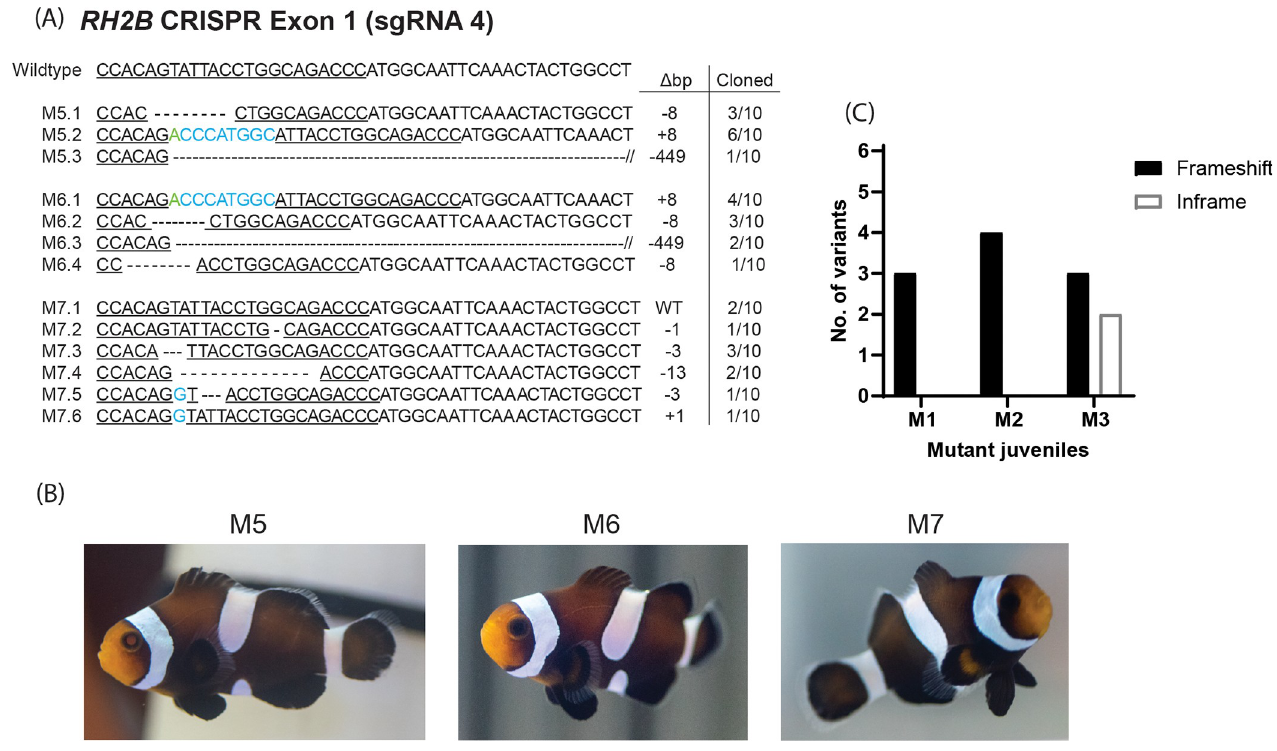
Fig 4. Genotype analysis of four-month-old RH2B mutant Amphiprion ocellaris . (A) Subcloned sequences belonging to A . ocellaris juveniles (clutch 11, sgRNA RH2B 4) with mutations at targeted sequences (underlined) located on Exon 1 of the RH2B opsin gene. Wildtype (WT) sequence is included for reference. Mutations included deletions (dashes), substitutions (green), and insertions (blue). Sequence labels on the left-side indicate mutant fish and allele no., while numbers on the right-side indicate the base pair change ( Δ bp) and the proportion of each allele out of the total number of cloned sequences for each fish. (B) Images of the RH2B mutant A . ocellaris juveniles. (C) Number of frameshift and in-frame mutations per RH2B mutant fish.